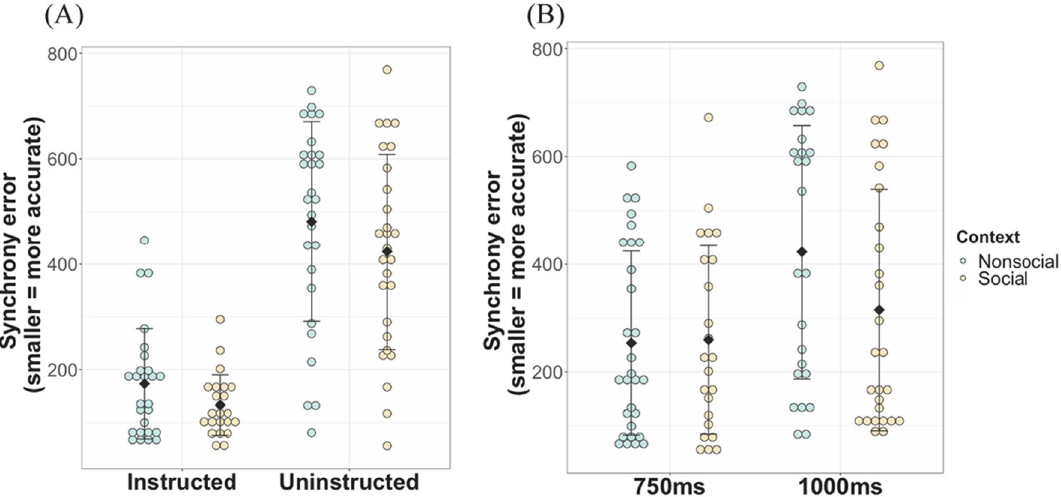
Figure 3. Synchrony accuracy by context, stimulus tempo and instruction conditions in children. Lower scores on the y axis indicate less synchrony errors and better accuracy. Coloured dots indicate individual data points, black diamonds indicate group mean and whiskers indicate standard error of the mean. ( A ) Synchronisation accuracy per context and instruction condition. ( B ) Synchronisation accuracy per context and stimulus tempo